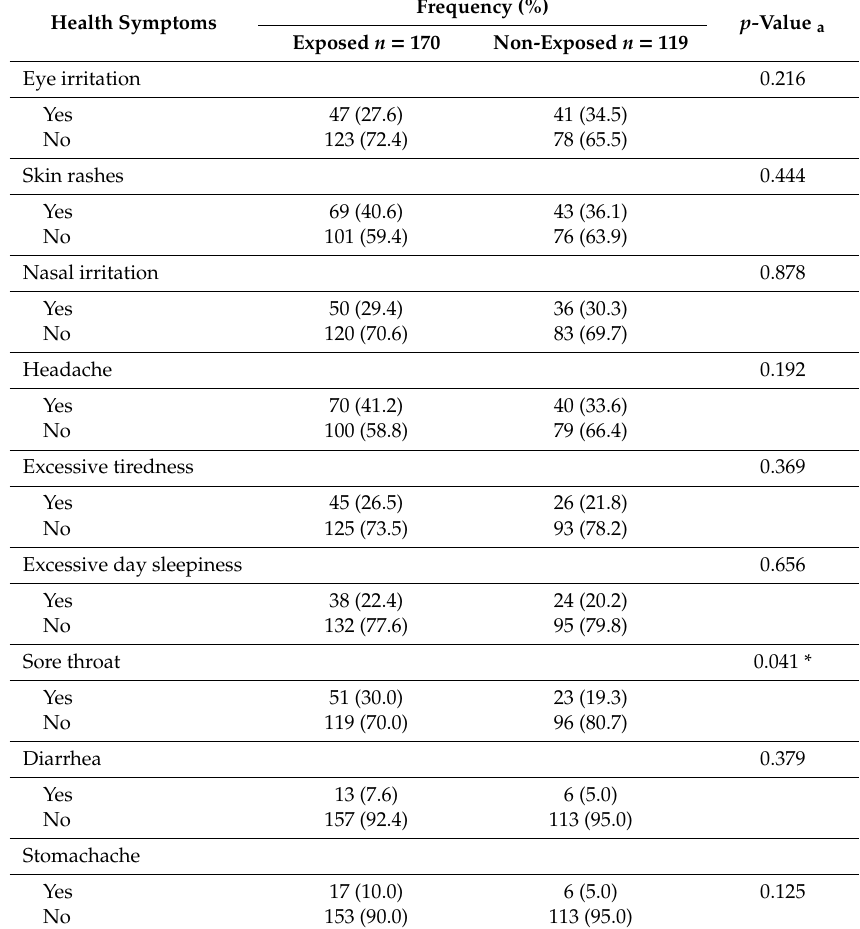
Table 2. Comparison of health symptoms in past one month among family members of residents of the exposed and unexposed groups to the solid waste dumpsite in Sabak.